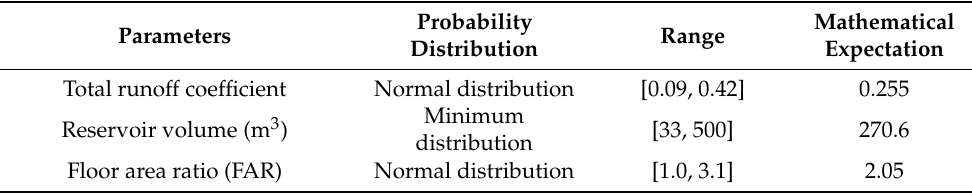
Figure 3. Methodology flowchart for multi-objective optimization of rainwater harvesting and utilization. Table 3. Values and probability distribution of model